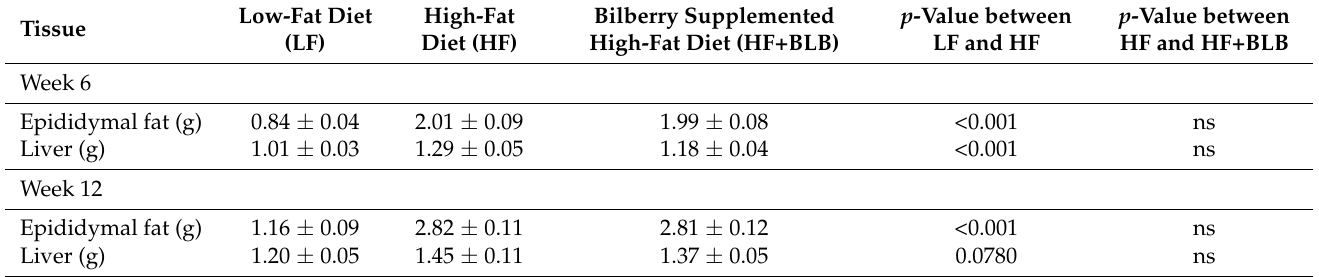
Table 1. Epididymal fat and liver weight. The mice received a low-fat diet (LF, 10% of energy from fat), a high-fat diet (HF, 46% of energy from fat) or a bilberry-supplemented high-fat diet (HF+BLB, 20% air-dried bilberry powder) for six or twelve weeks. The weights were analyzed with a one-way ANOVA and a Bonferroni multiple comparisons test. The results are expressed as grams; values represent mean ± SEM; n = 12 mice in each group; ns = not significant ( p >